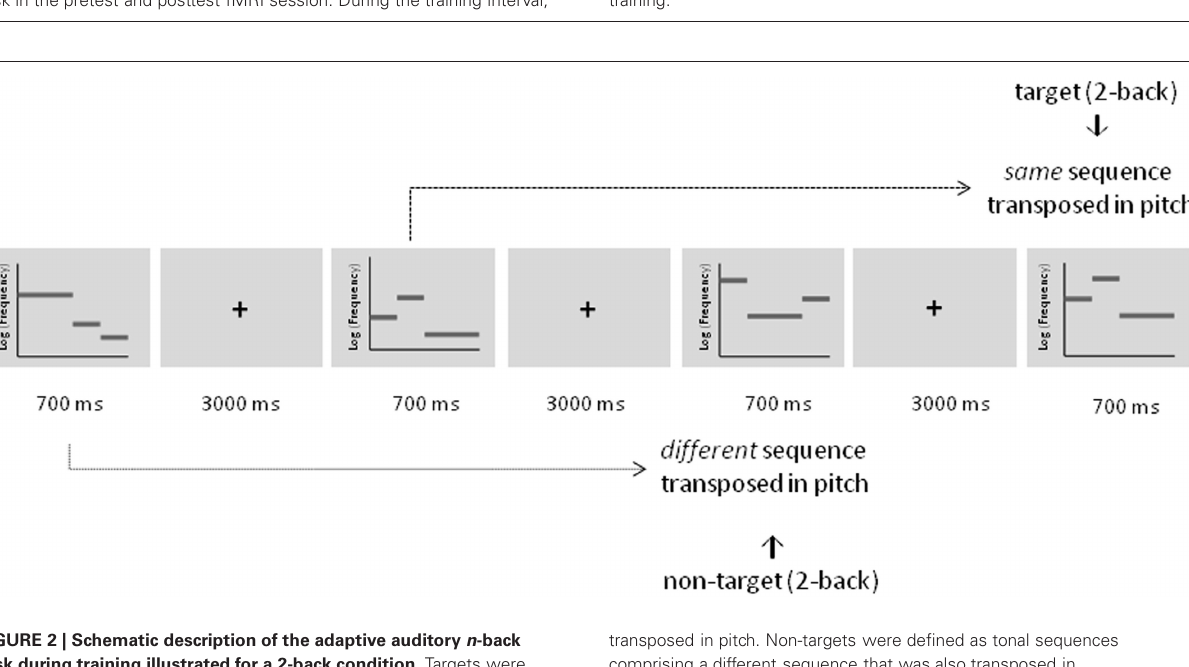
the auditory training group was trained on an adaptive n -back task using auditory tonal sequences, whereas the control group did not receive any training.